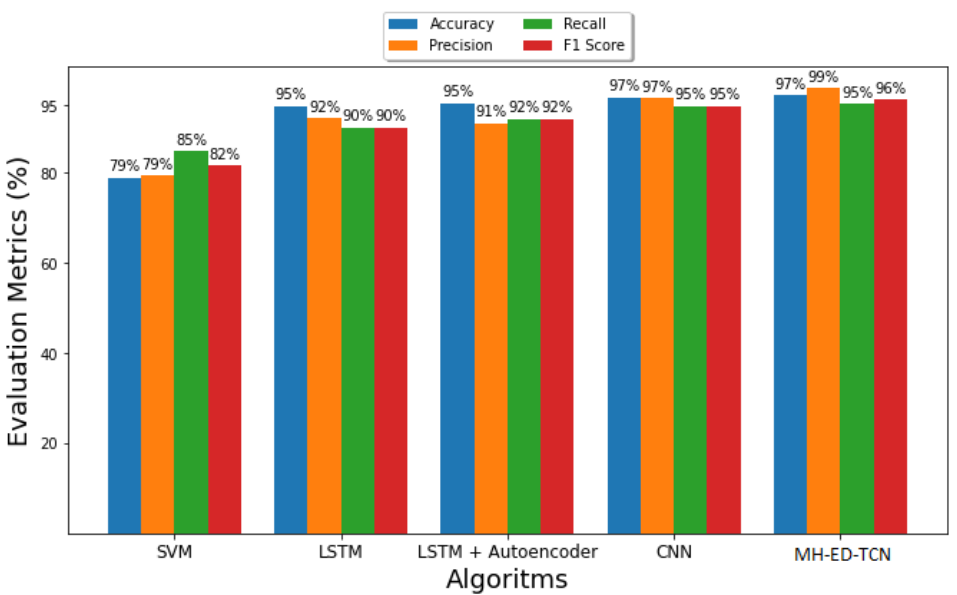
Figure 4. The comparison of the different machine learning algorithm compared to the proposed